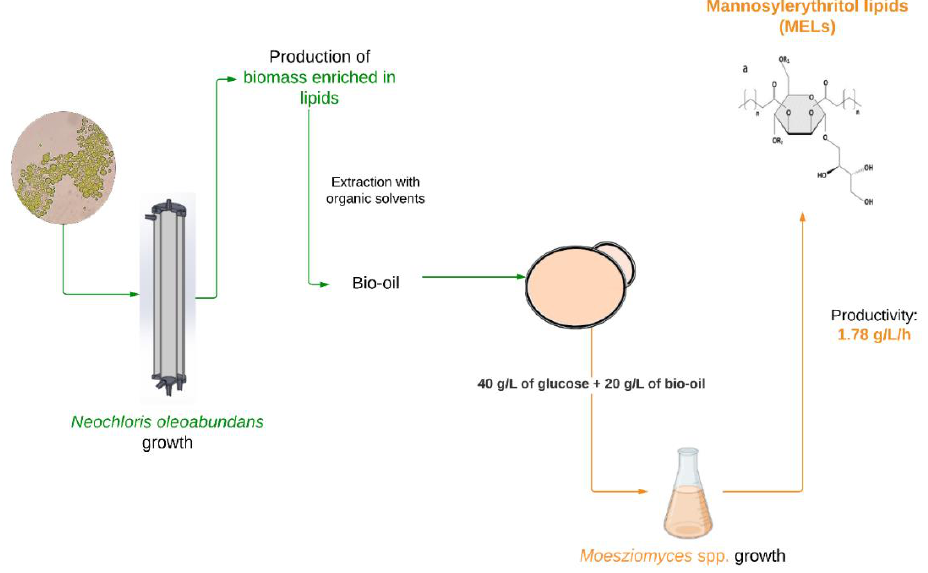
Figure 1. Schematic overview of MELs production from algae-derived bio-oils, produced by Neochloris oleoabundans.